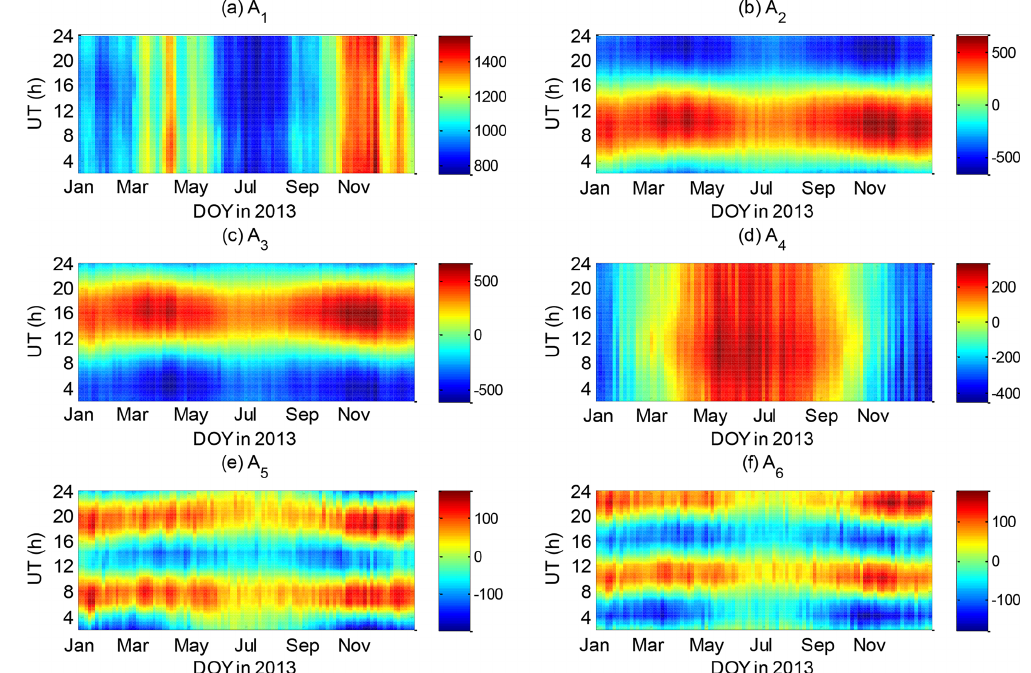
Figure 4. Associated coefficients A 1 – A 6 of the first six orders of EOF base functions based on Eq. (6), and A 1 – A 6 plotted against UT and